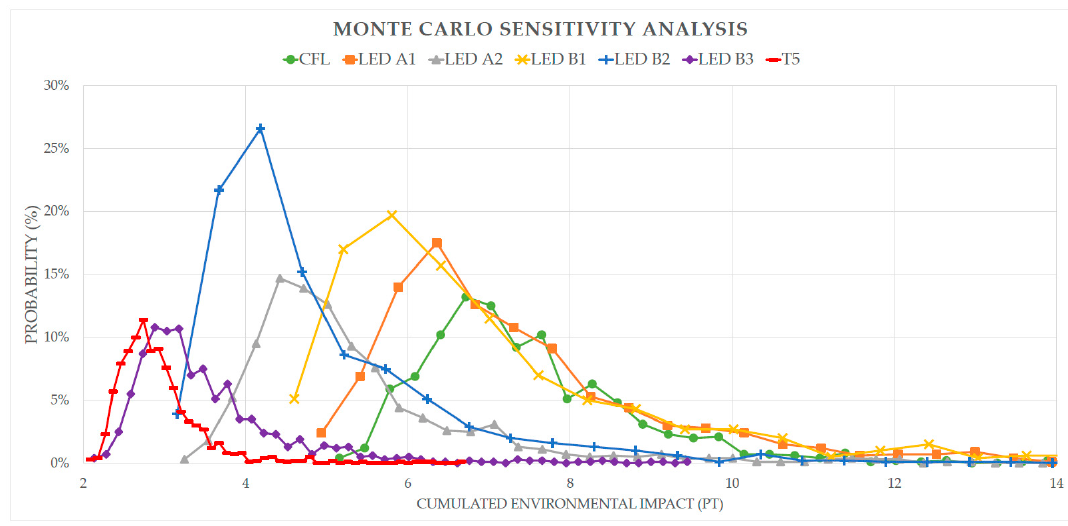
Figure 7. Monte Carlo sensitivity analysis.